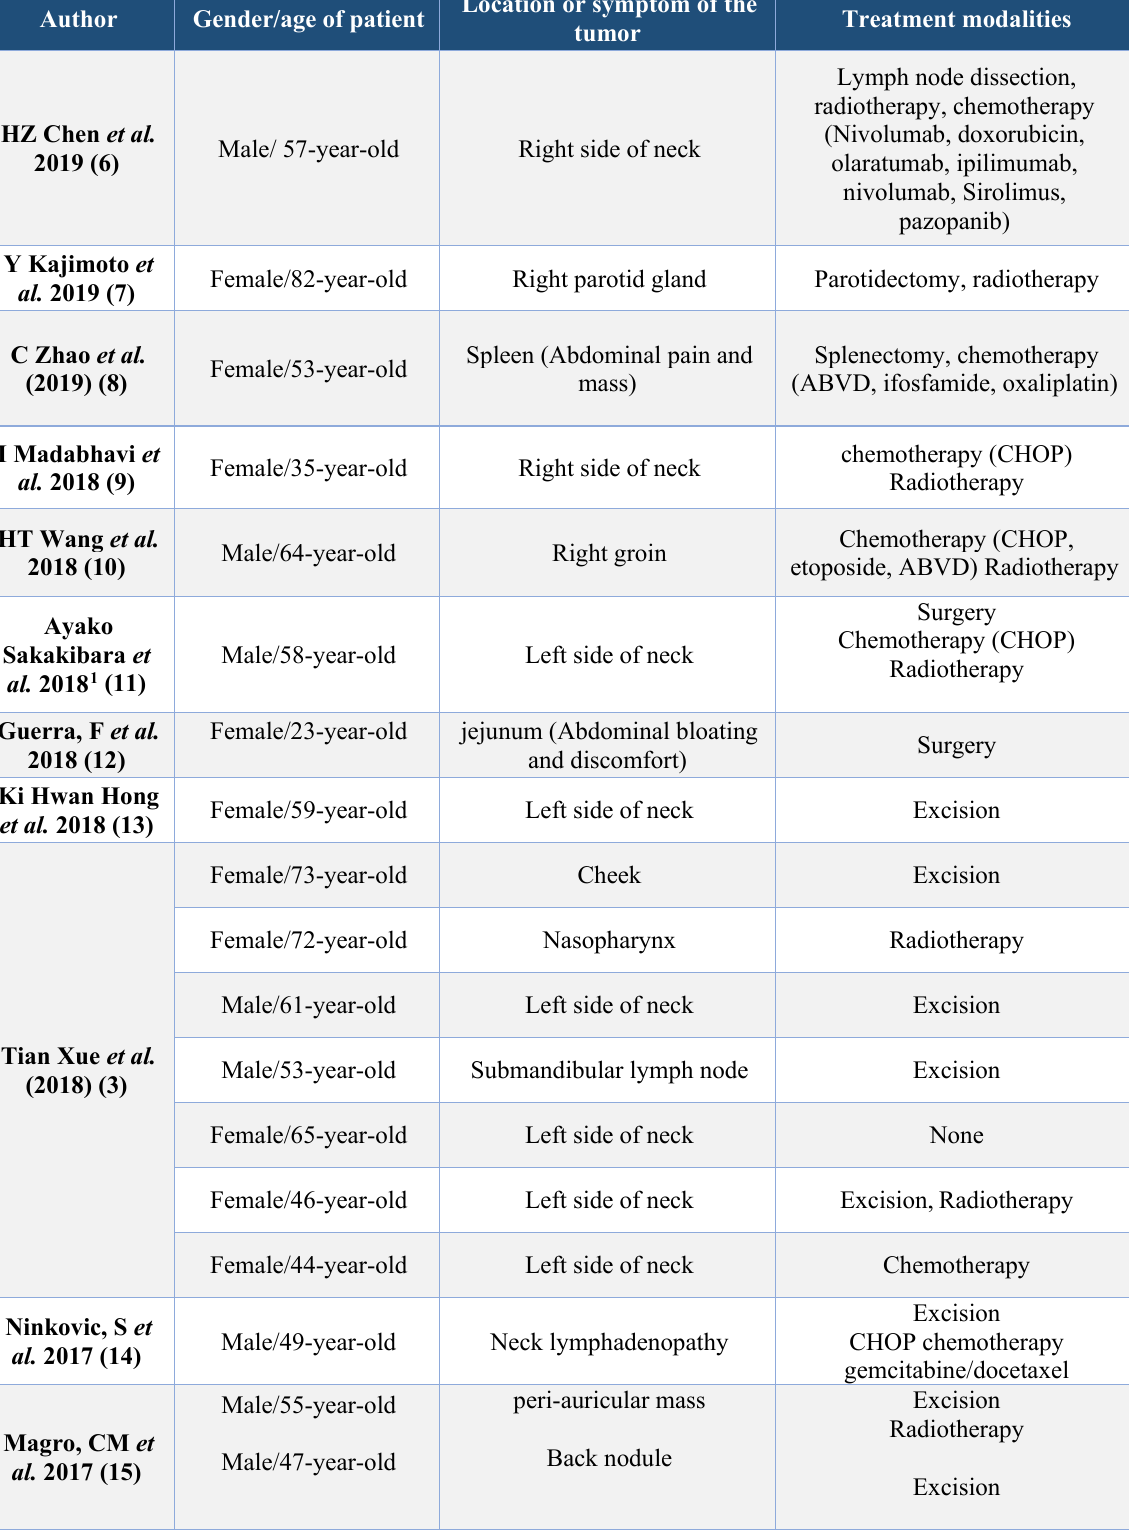
Table 1. Published cases of interdigitating dendritic cell sarcoma (IDCS) from 2015 to